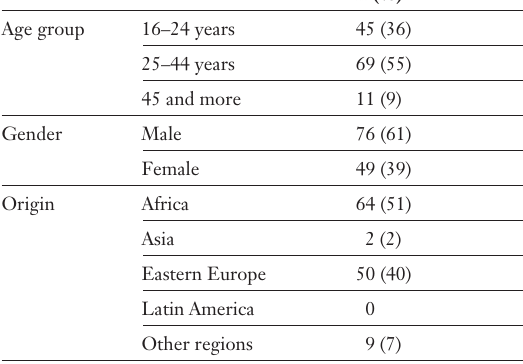
Demographic data of 125 immigrants with chest x-ray sugges- tive of TB.